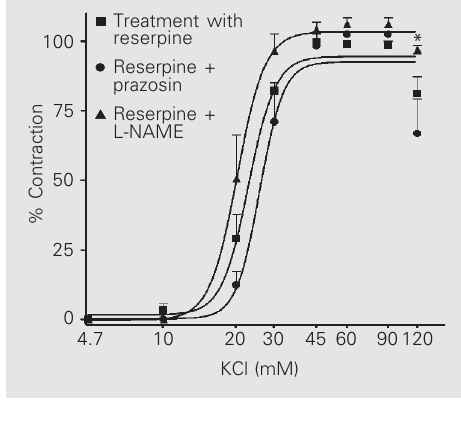
Figure 5. Effect of prazosin and L-NAME on the contractile re- sponses induced by KCl in the anococcygeus muscle isolated from rats treated with